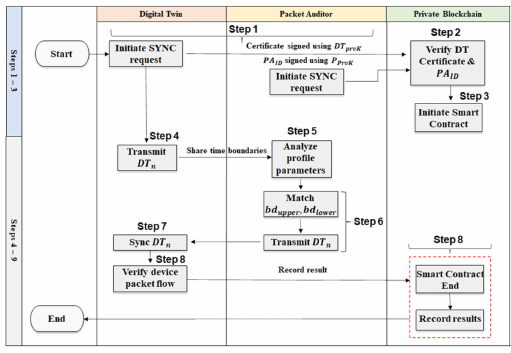
Figure 3. Digital Twin